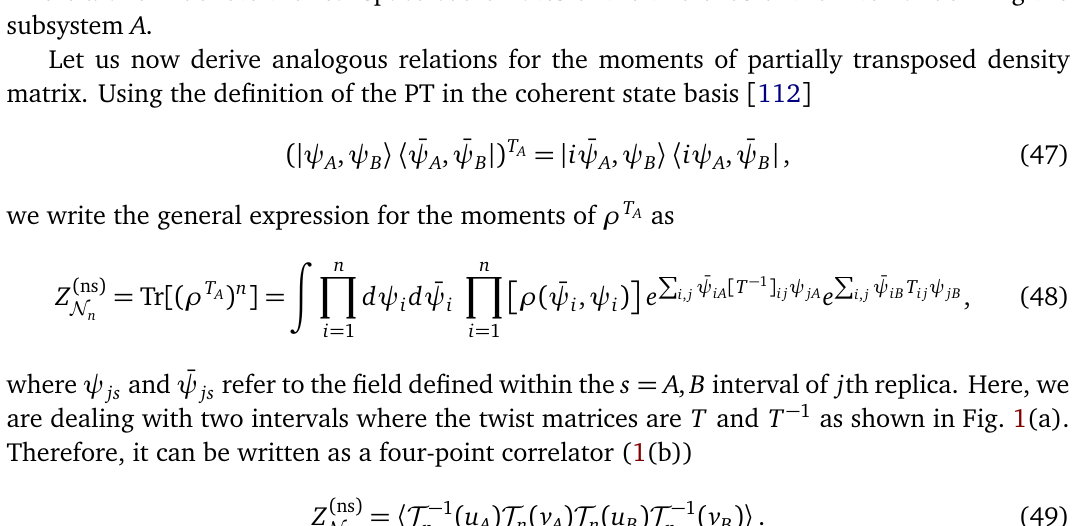
Figure 1: (a) Spacetime manifold associated with Z Fig.2.6 The Euclidean geometry for computing the matrix elements of powers of the reduced andtracethereof,pictoriallydepicting(2.3.4).Wehaveillustratedthesituation densitymatrix ! A operator e i α F A twists the boundary condition of the cycles between two successive 3 matrixelementswith inwhichwegluethreecopiesofthereplicatedpathintegralstoconstruct ! A theidentificationsbetweenboundaryconditionsonthereplicacopiesindicatedbythe arrows .The finaltracetocomputethethirdRényientropyisindicatedbythe dottedline sheets, shown as the green path with dashed lines. (b) Equivalent picture in terms of twist field where we define a multi-component field on a single spacetime correspond to the left and right Schwinger-Keldysh fields, respectively. So instead of(2.3.4), weendupwitha morecomplicatedexpression,cf.,Fig.2.7.